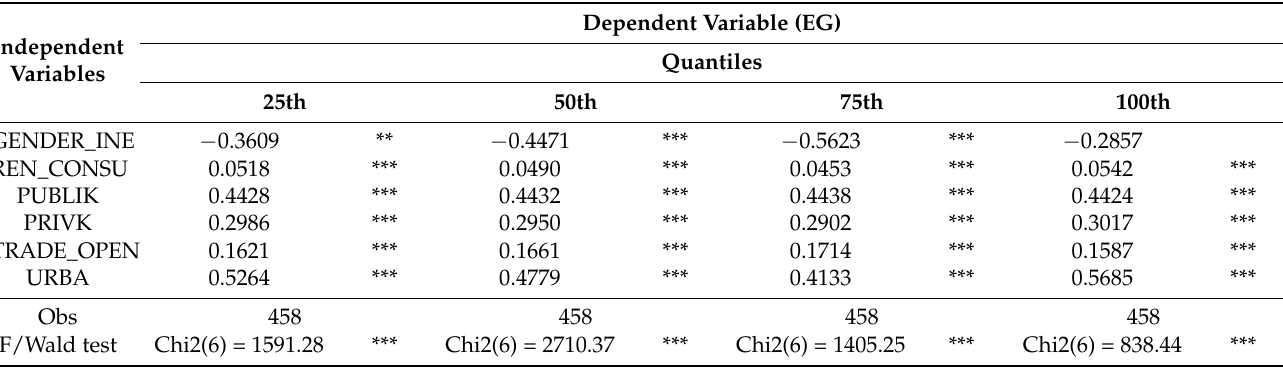
Table 10. QvM estimation (robustness check).